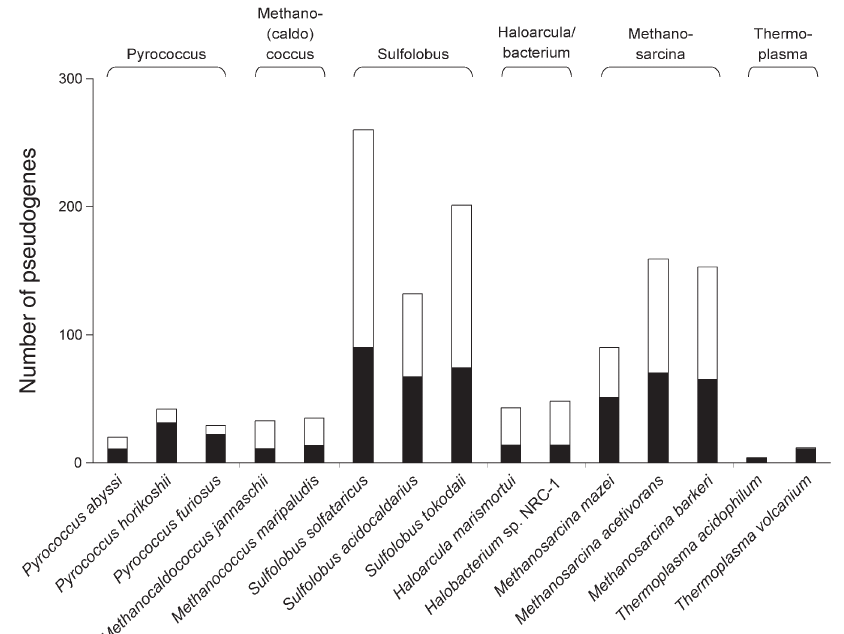
Figure 2. Numbers of positional (filled bars) and non-positional pseudogenes (open bars) in archaeal